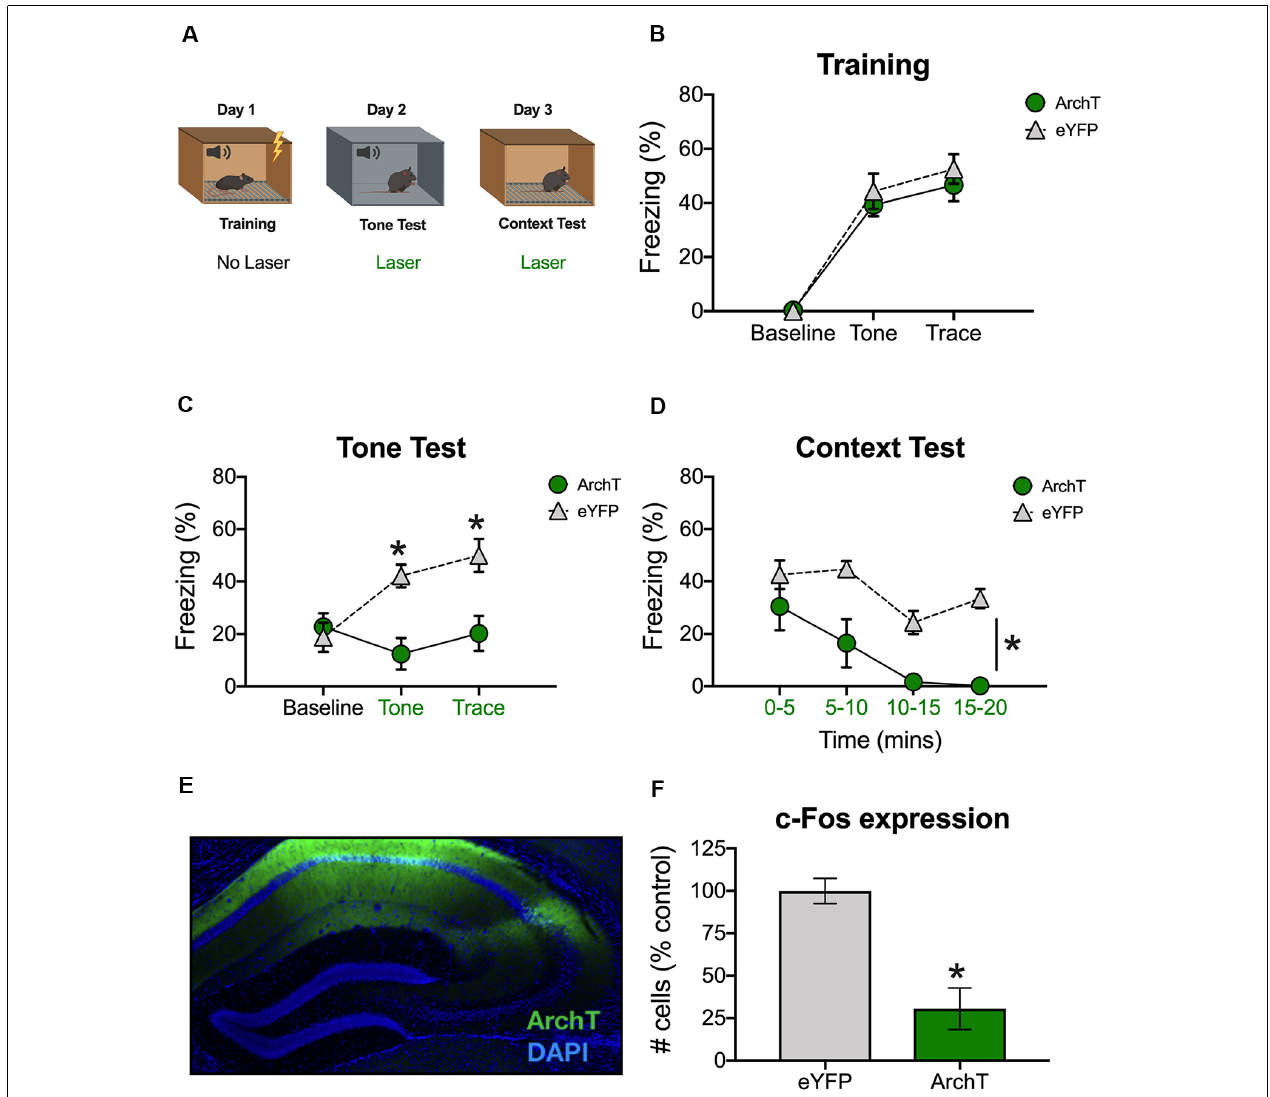
FIGURE 1 | Inhibition of dCA1 impairs trace fear memory retrieval. (A) Schematic of behavioral paradigm. On day 1, animals underwent trace fear conditioning without laser stimulation. The next day, mice underwent a tone memory test in a novel context with green light delivered to dorsal CA1 (dCA1) during each trial. Twenty-four hours later, mice were placed back in the conditioning environment for a context memory test. Green light was delivered to dCA1 during the entire context test. (B) Freezing during the training phase of trace fear conditioning (Mean ± SEM). (C) Freezing during the tone test (Mean ± SEM). (D) Freezing during the context test (Mean ± SEM). (E) Example of virus expression. Green, ArchT; Blue, DAPI. (F) c-Fos expression in eGFP and ArchT mice after the context test. Green x-axis labels denote periods during which the laser was delivered. In all panels, green represents the ArchT group and gray represents the control